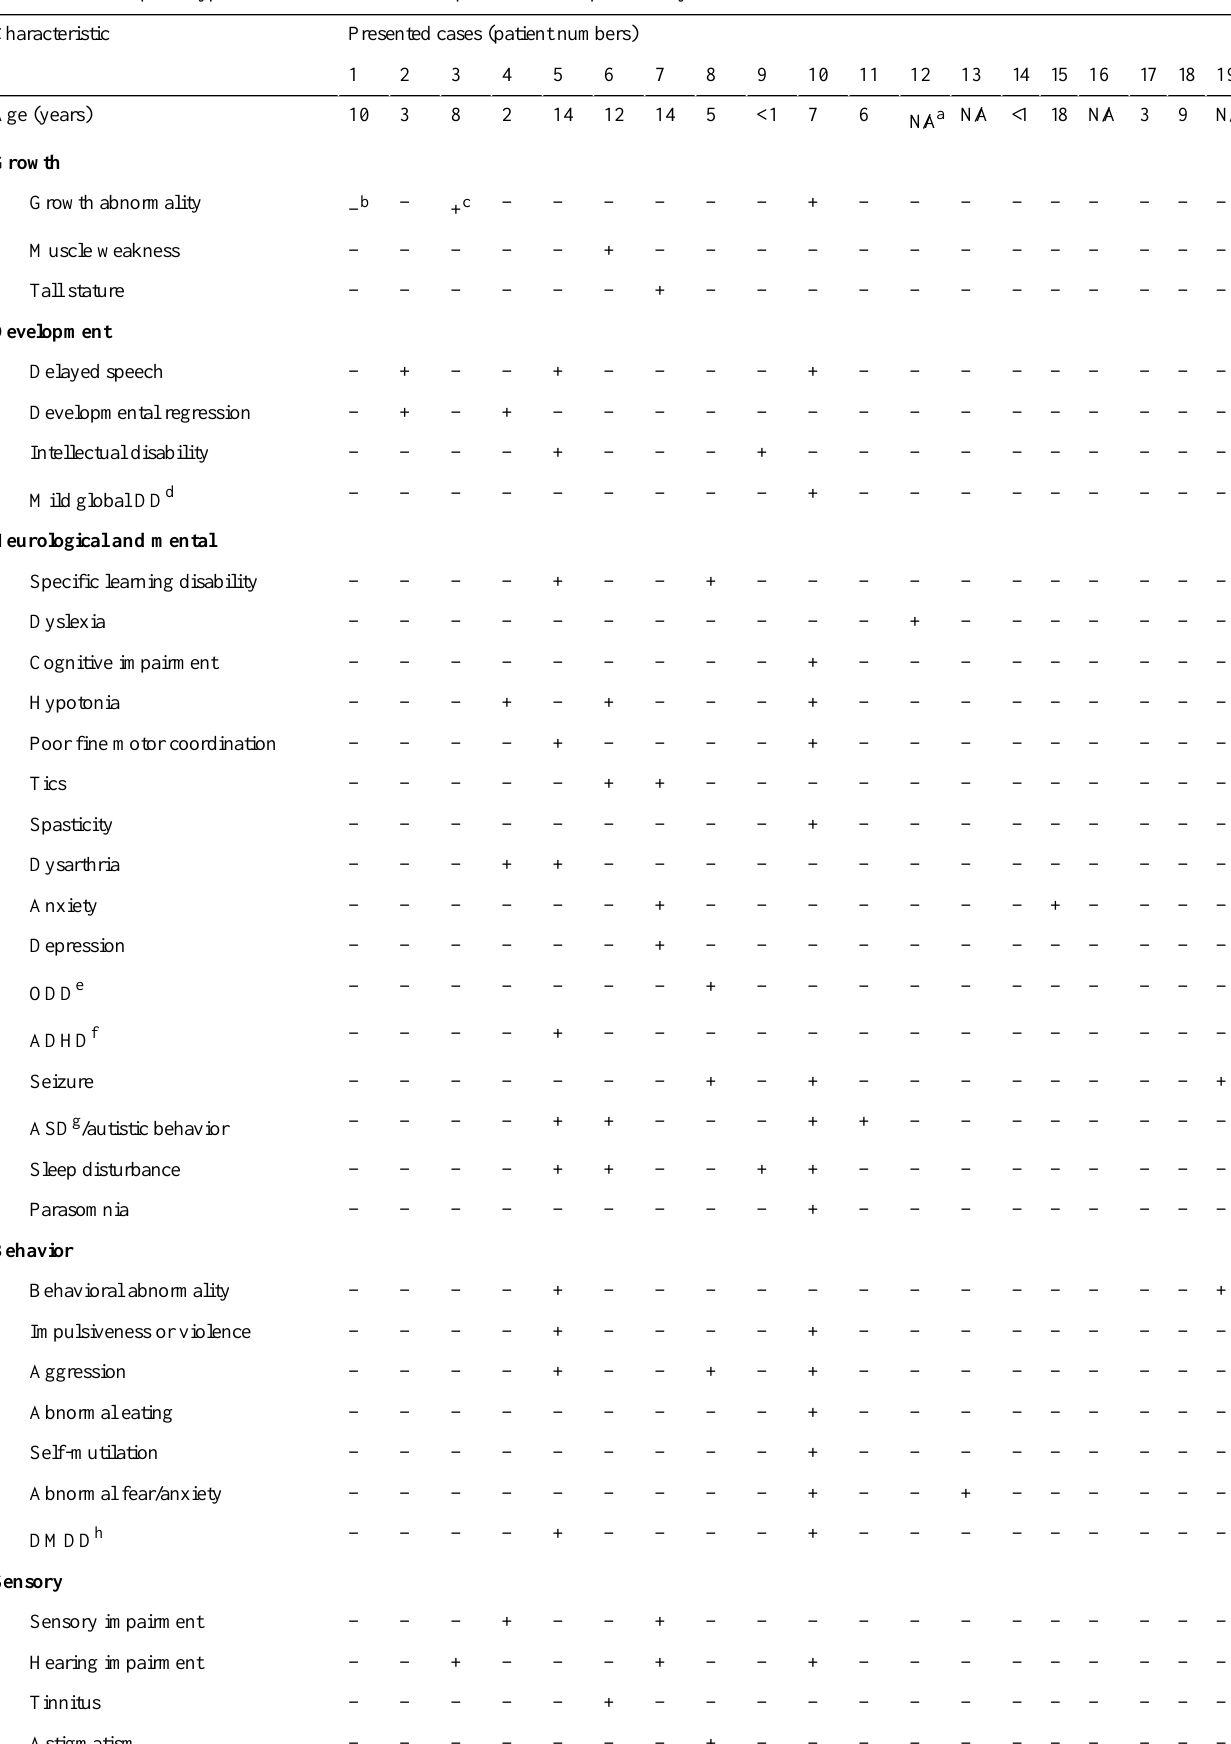
Table 1. Selected phenotypic features in 19 cases of 16p13.11 microduplication syndrome. Presented cases (patient